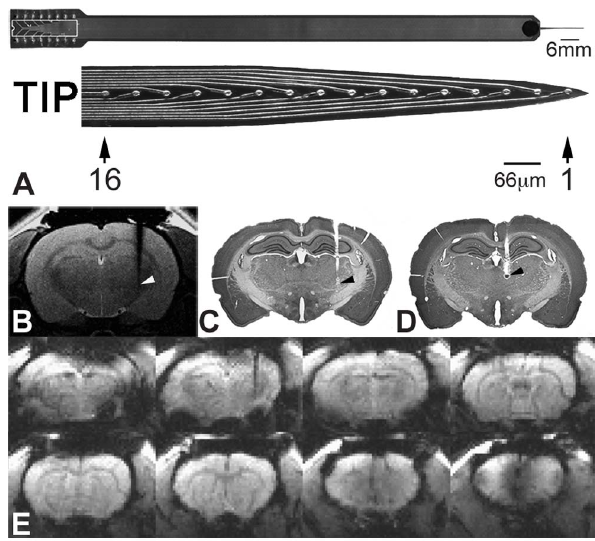
Figure 1. Stimulation electrode and its MR compatibility. Photograph of the electrode and tip (TIP) are displayed in (A). Coronal T2 image with the implanted electrode track in (B), Nissl-stained section showing the location of the electrode tip in the VP (C) and the MT (D). Eight coronal gradient-echo EPI images are presented from caudal to rostral